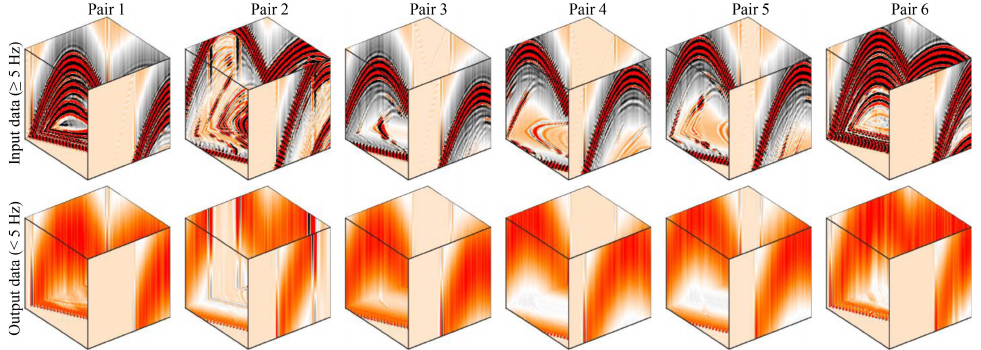
Figure 5. An illustration of six randomly chosen training data pairs. Each pair consists of an input 3D data volume ( (cid:62) 5 Hz) in the top row and an output LF volume Y (<5 Hz) in the bottom row. The cube size is 64 × 64 × 64 along the time, receiver, and shot axes, respectively, i.e., n time × n rec × n src